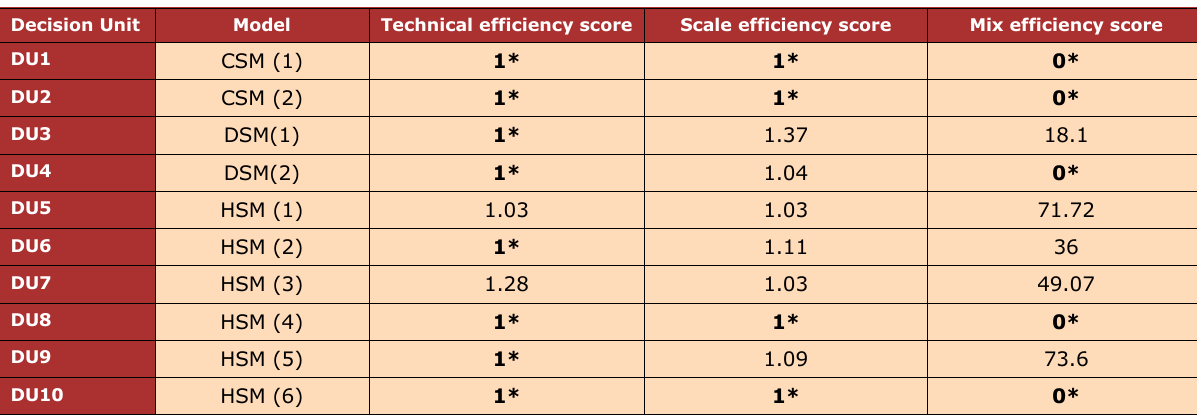
Table 9. Inefficiency terms for the setting with high interaction level